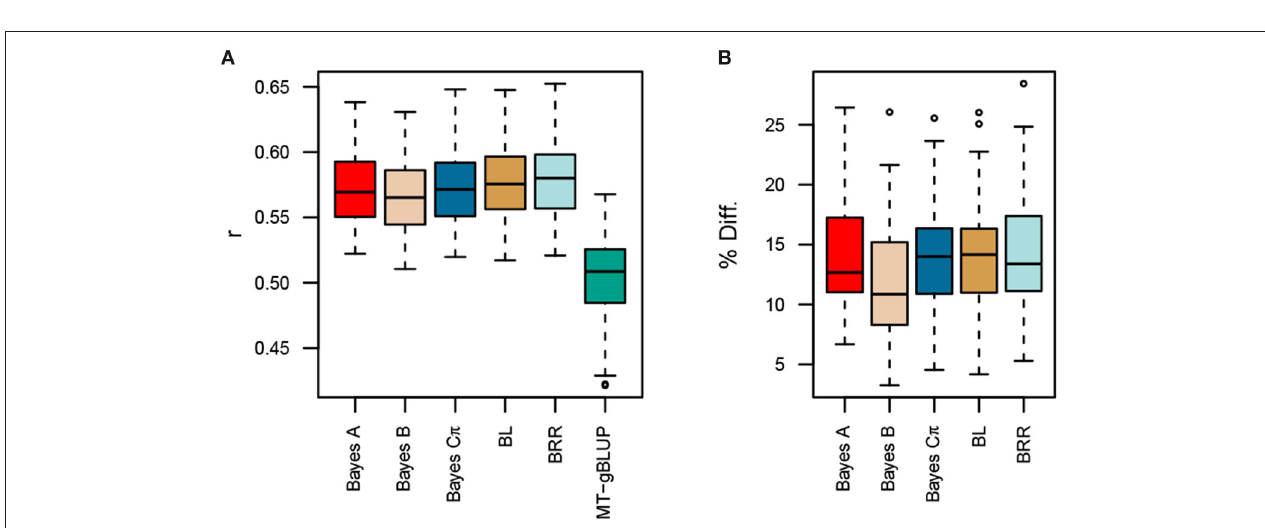
FIGURE 4 | Comparison of prediction accuracies for multi-kernel trait-specific BLUP models (MK-TGRM-BLUP) and a multi-trait gBLUP approach (MT-gBLUP). The multi-trait gBLUP model used phenotypes for the nine fatty acid traits and total lipid content measured via near-infrared spectroscopy (NIRS) to predict total lipid content. Prediction accuracy was assessed using five-fold cross validation with 50 resampling runs. Since there is a small overlap between lines in the diversity panel, which have fatty acid phenotypes, and lines in the Elite Panel, these common lines were always included in the training set. The testing set is then 20% of the lines that only have NIRS phenotypes. The correlation between predicted genomic breeding values in the testing population and the average of observed phenotypes across locations is shown in (A) . Panel (B) shows the percent improvement relative to MT-gBLUP for each MK-TGRM-BLUP approach. BL, Bayesian LASSO; BRR, Bayesian ridge regression; r , Pearson’s correlation